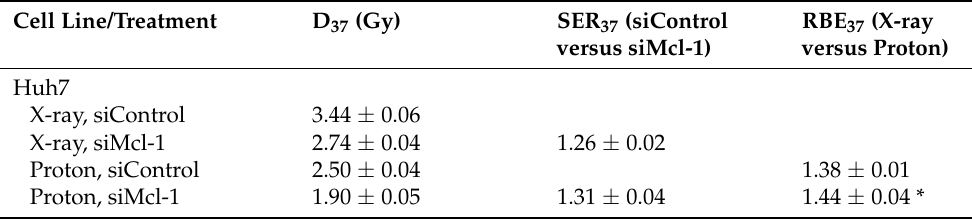
Figure 6. Effects of Mcl-1 depletion on proton radiosensitization in Huh7 cells. ( A ) siRNA-mediated knockdown of Mcl-1 in Huh7 cells. Western blot confirmed reduction of Mcl-1 protein level. β -actin was used as a loading control. Relative expressions of Mcl-1 normalized to β -actin were presented. The data represent the mean ± S.D. (n = 3); *** p < 0.001. ( B ) Clonogenic survival curves showed that proton RBE was increased by Mcl-1 knockdown. The data represent the mean ± S.D. of three independent experiments performed in triplicate. ( C ) Flow cytometry showed that the depletion of Mcl-1 enhanced proton-induced apoptosis. The data represent the mean ± S.D. (n = 3); * p < 0.05; ** p < 0.01; *** p < 0.001. ( D ) Correlation analysis between Mcl-1 level and RBE 37 of HCC cell lines. The normalized protein expression data and RBE values of five HCC cell lines, Huh7, Hep3B, HepG2, SK-HEP-1 and SNU449 was used for the analysis. Pearson correlation coefficient (r) and p -value are shown. Table 2. Radiation response parameters of Mcl-1 depleted Huh7 cells.